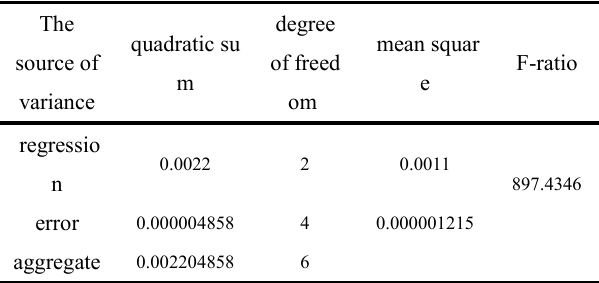
Table 6 Analysis of variance